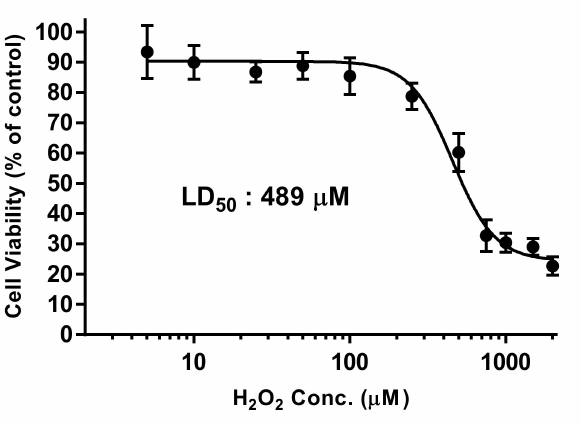
Figure 25. Determination of the H 2 O 2 lethal dose (LD50, µ M) after 24-h incubation of diffSH-SY5Y cells. Values are the Mean ± SD of four different experiments performed in quadruplicate (r2: